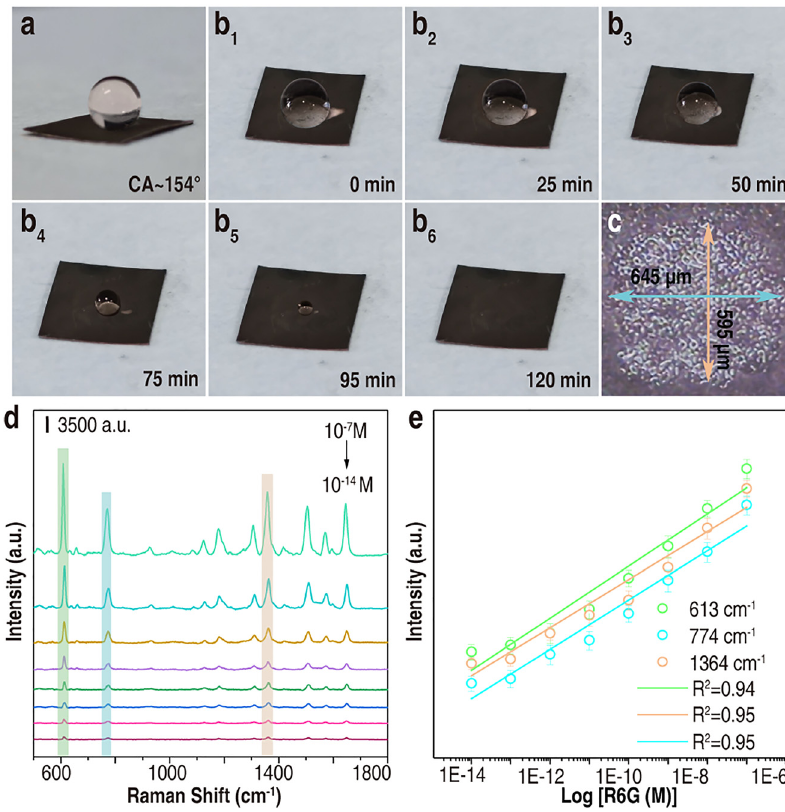
Figure 7: (a) Water droplet